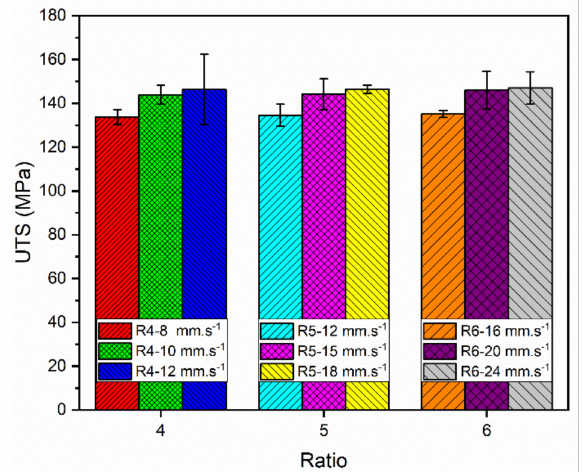
Figure 7. Ultimate tensile strength (UTS) is plotted in different ratios.